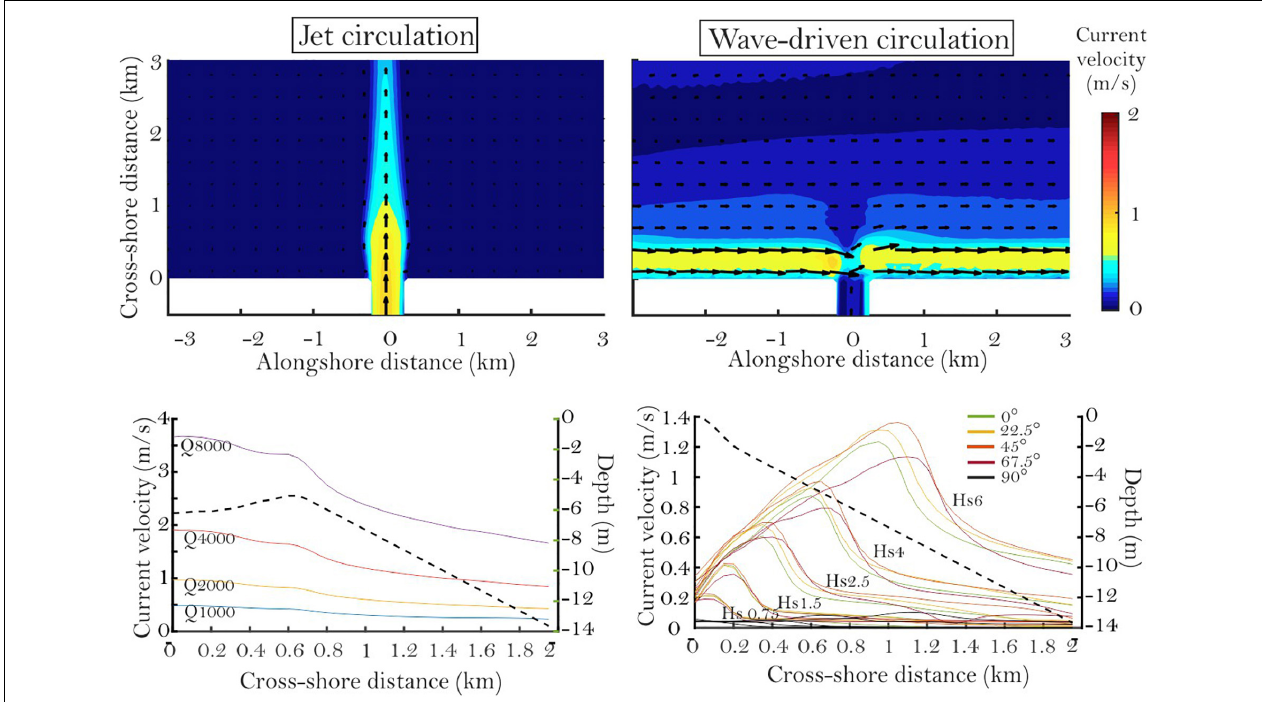
FIGURE 2 | Jet (left) and wave-driven (right) circulation types with no RMB. Top plots show a jet at Q = 2000 m 3 /s and LSC conditions at Hs 2.5 m and 45 ◦ incidence. For the bottom plots, jet velocities are taken on the jet centerline, whereas LSC velocities are taken on a profile at –1.5 km alongshore. Dotted lines show the profile